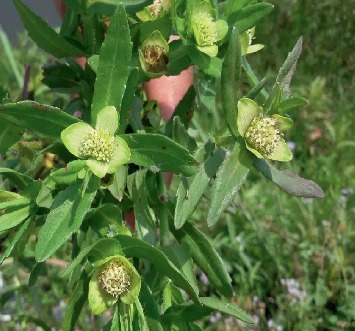

Enydra fluctuans.